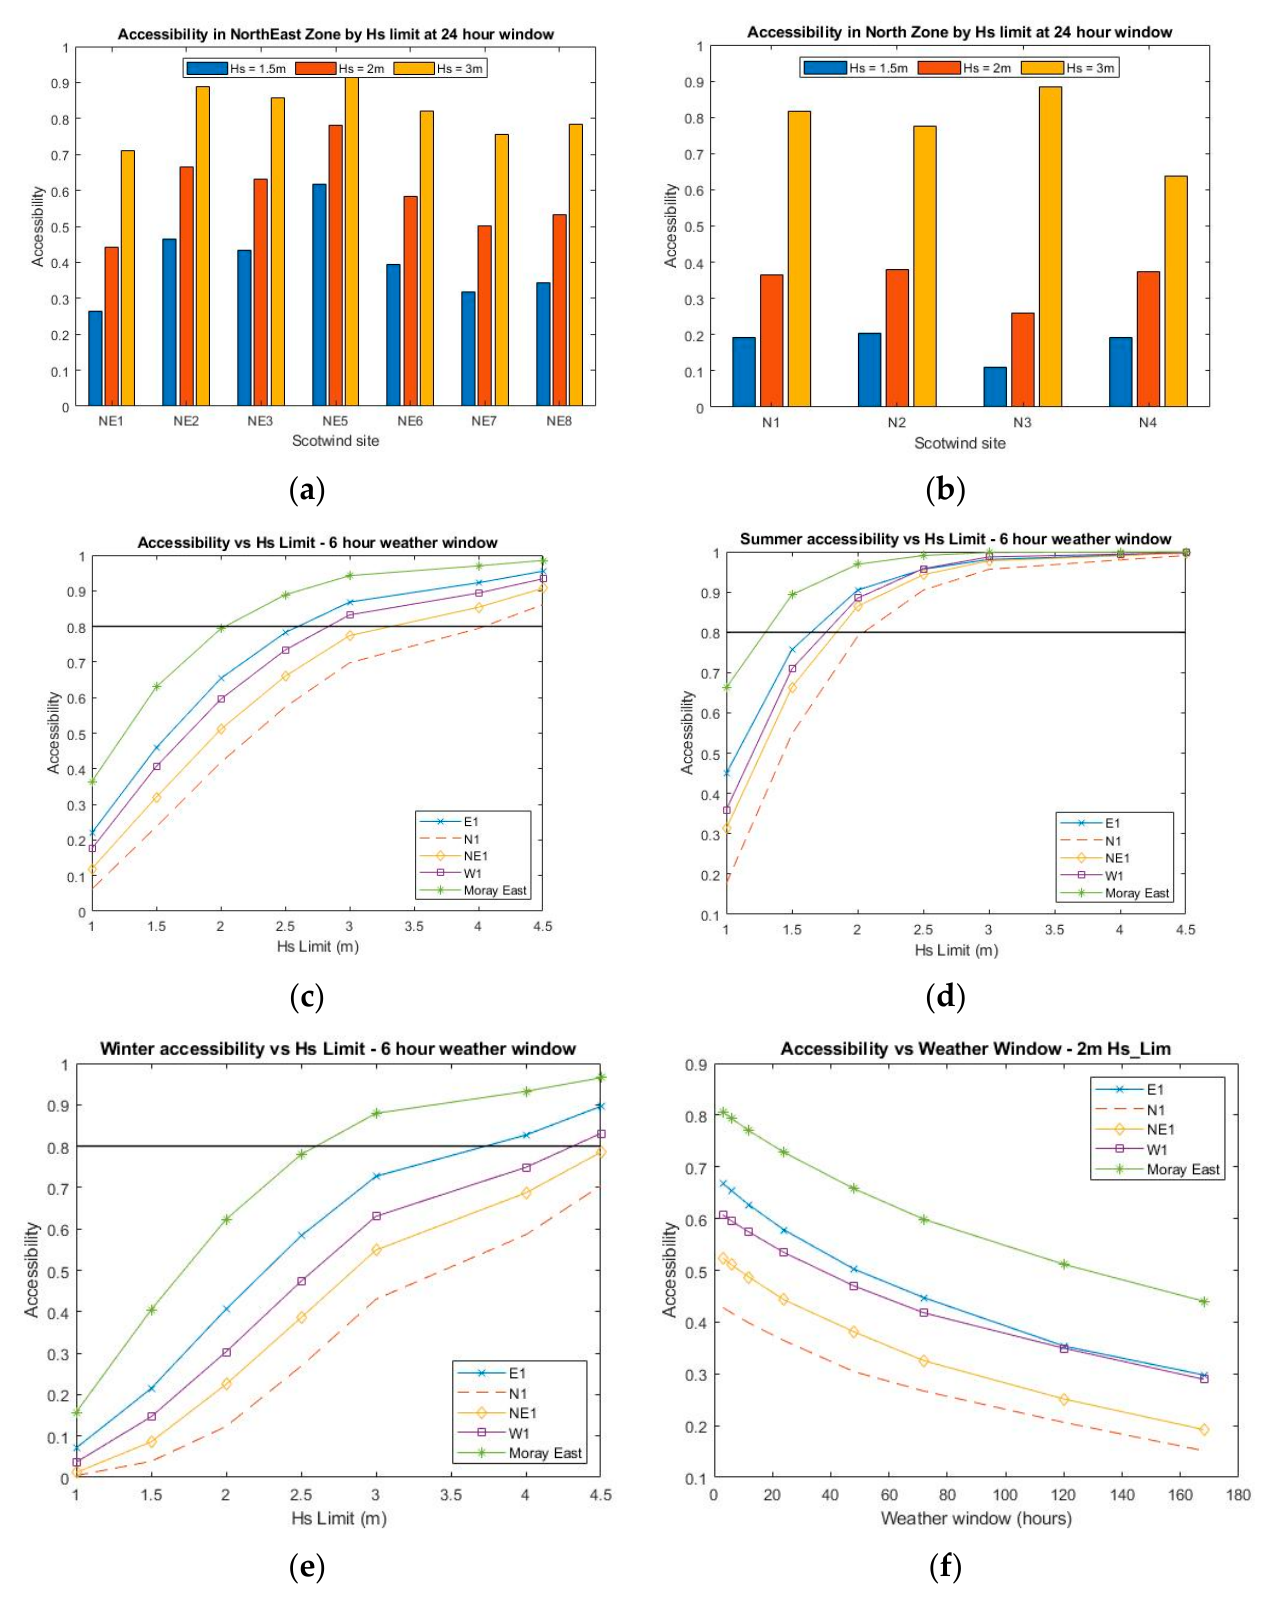
Figure 6. ( a ) accessibility of NE zone sensitivity to H S limit, ( b ) accessibility of North zone sensitivity to H S limit, ( c ) sensitivity of accessibility to Hs limit, ( d ) sensitivity of accessibility to Hs limit in summer, ( e ) sensitivity of accessibility to Hs limit in winter, ( f ) sensitivity of accessibility to weather window.